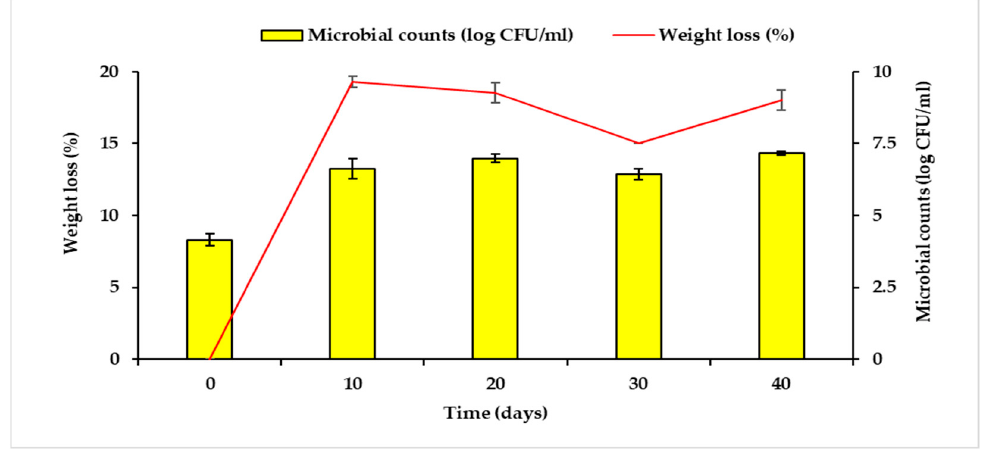
Figure 4. Weight loss percentage of the PS microplastics and the microbial counts in Bushnell Haas (BH) medium inoculated with strain AYDL1. The experimental flasks were shaken for 40 days at 150 rpm and 17 ± 2 °C. Data represent mean ± standard deviation (SD), n = 2. Table 2. Removal rate constant and half-life of PS microplastics in the culture of strain